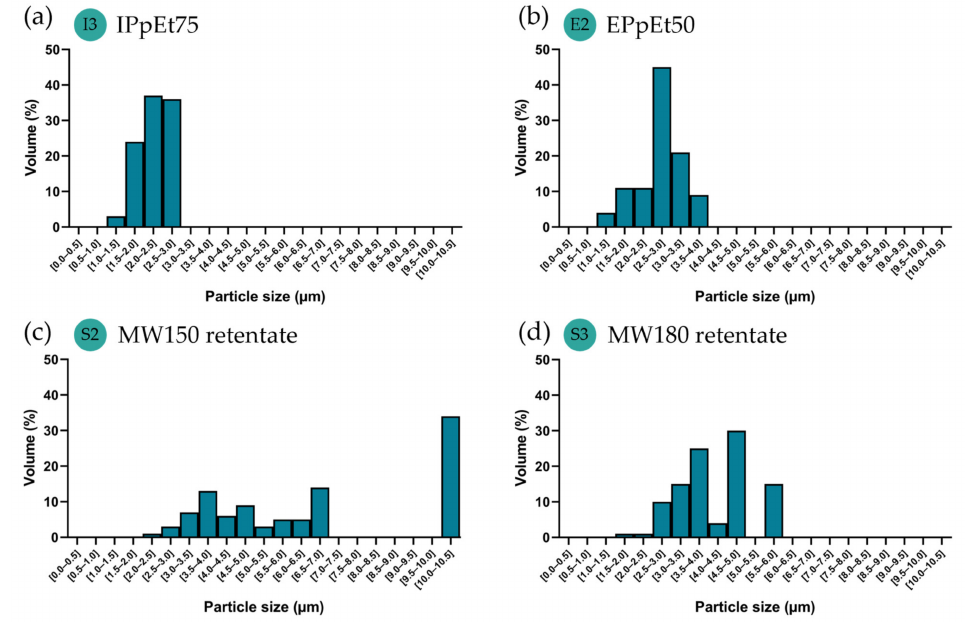
Figure 4. Particles volume distribution histograms based on the 2D particle size quantified in the SEM micrographs, correspondently made with ( a ) IPpEt75, ( b ) EPpEt50; ( c ) MW150 retentate, and